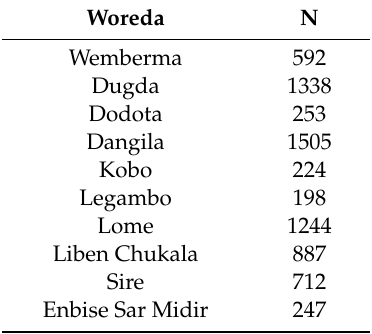
Table 1. The number of field boundaries (N) manually digitized using CLE for each